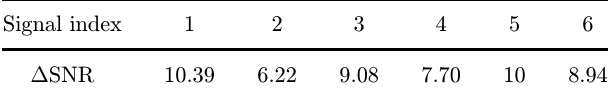
Table 3. Results of applying AR based method to real data.